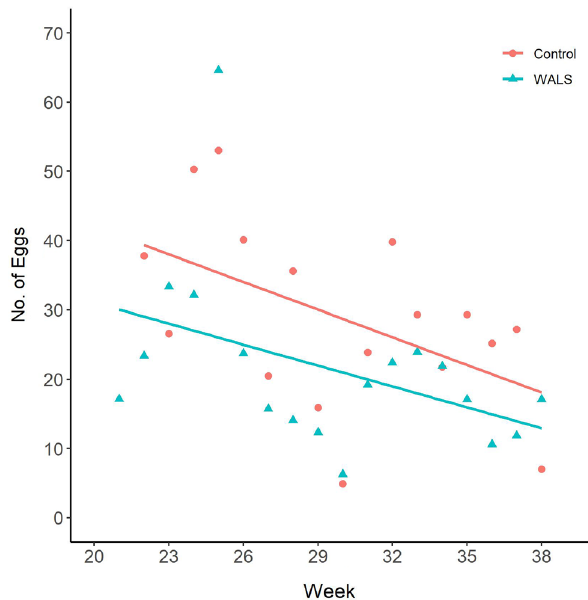
Fig. 11 Average number of eggs collected from the ovitraps for each week in untreated control and WALS sites